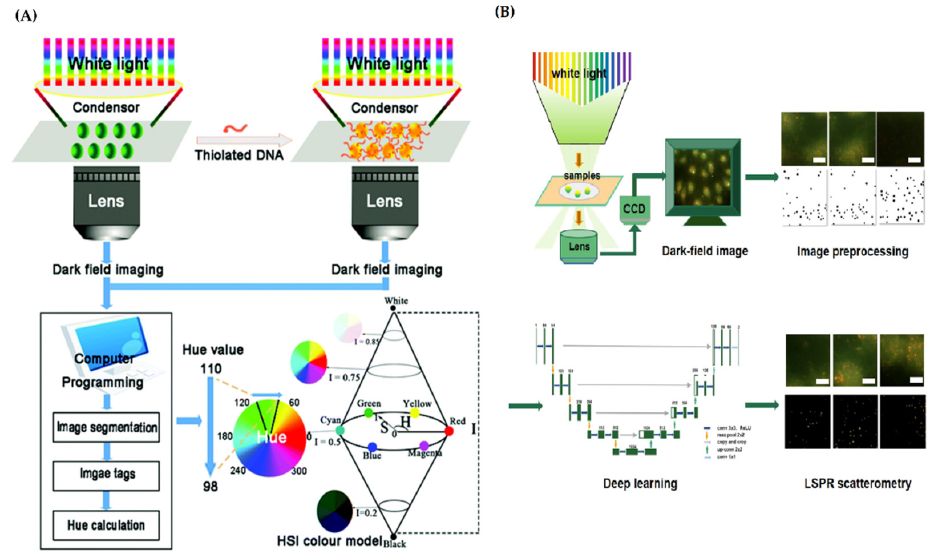
Figure 3. ( A ) Schematic illustration of the HSI color coding analysis for the attachment of thiolated DNA to Au NPs based on the HSI color-coding of single PNPs, the procedure of image processing through computer programming, and the HSI color model. Reprinted with permission from [26]. Copyright 2016 Royal Society of Chemistry. ( B ) Schematic illustration of the scattering light analysis process of plasmonic nanoparticles in living cells using deep learning. Reprinted with permission from [28]. Copyright 2021 American Chemical